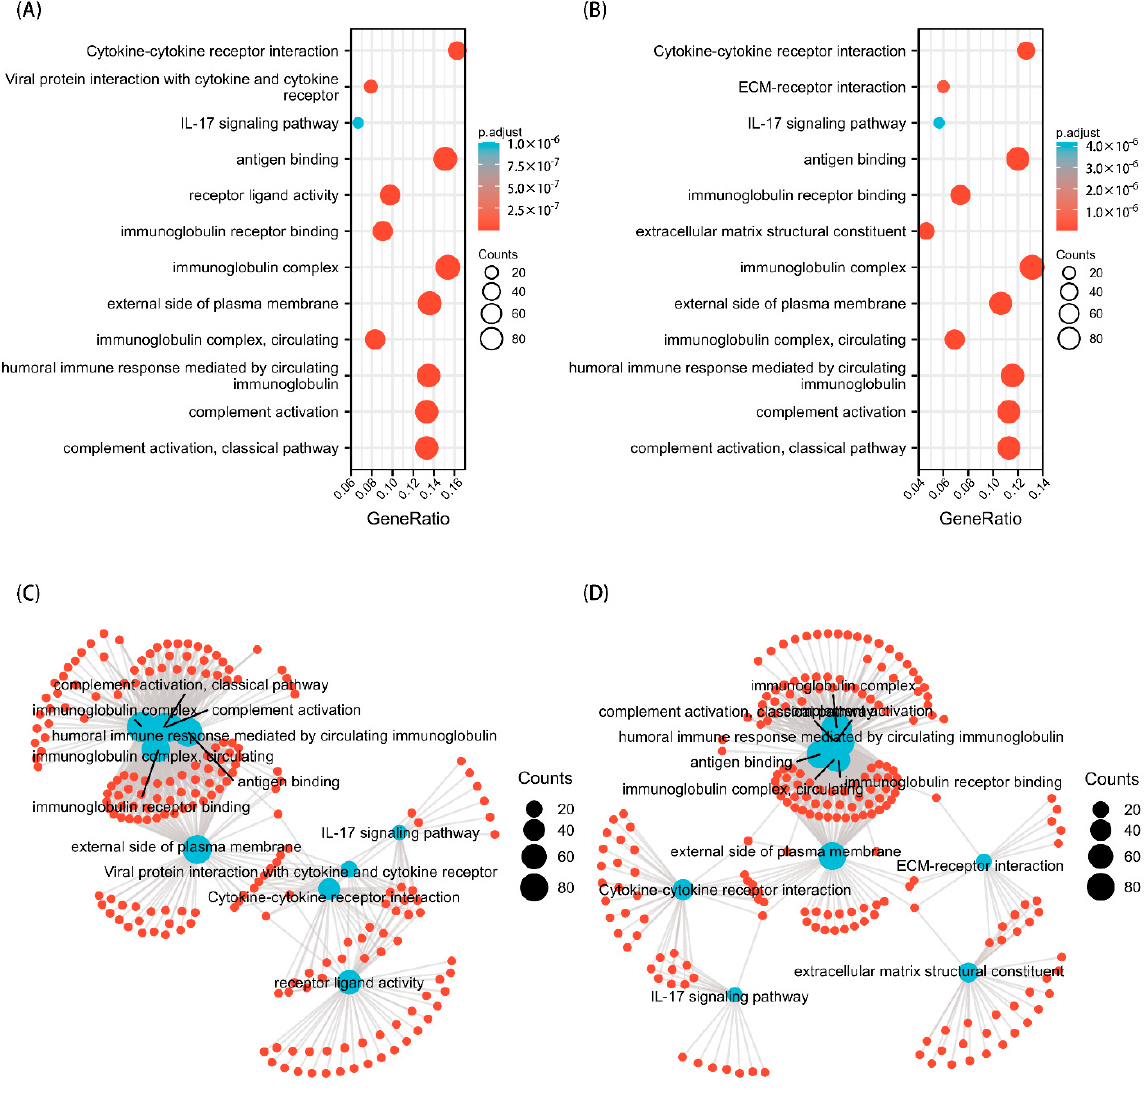
Figure 8. GO/KEGG enrichment analysis. ( A ) GO/KEGG analysis for TPM3. ( B ) GO/KEGG analysis for TPM4. ( C ) Network visualization of GO/KEGG enrichment analysis for TPM3. ( D ) Network visualization of GO/KEGG enrichment analysis for TPM4.